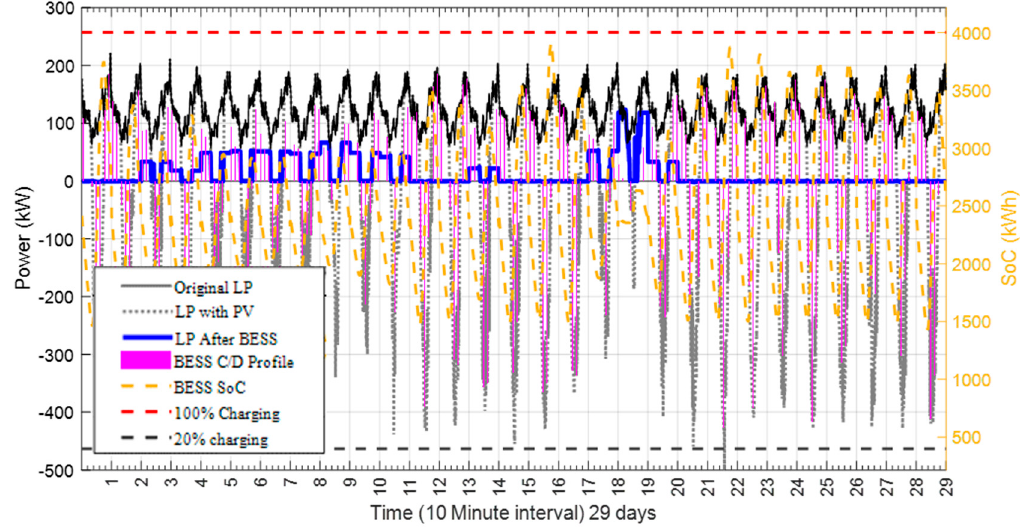
Figure 17. Load profiles for 100% PV penetration and BESS for RPFS with AD = 0.4 (1–29 February 2016).